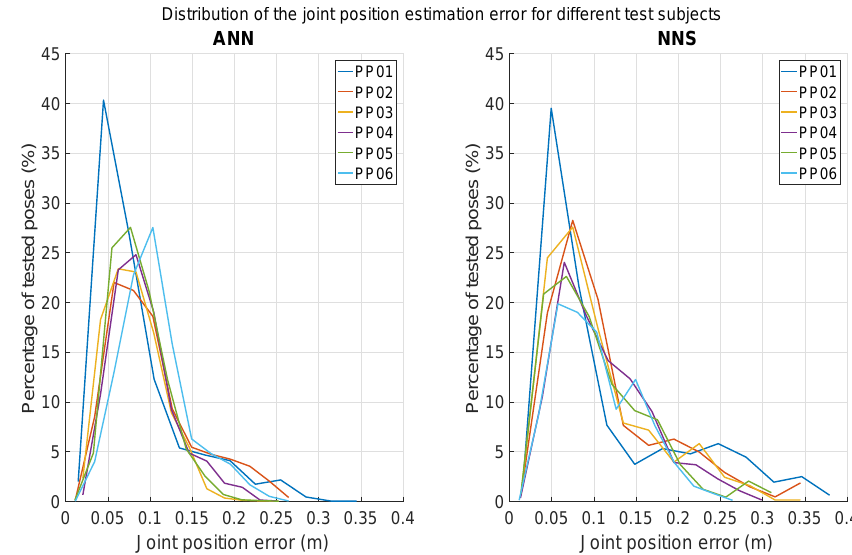
Figure 9. Distribution of joint position errors (with bins of 3 cm) for all scenario 1 activities for each subject. The left distribution shows ANN results, whereas NNS results are shown on the right.